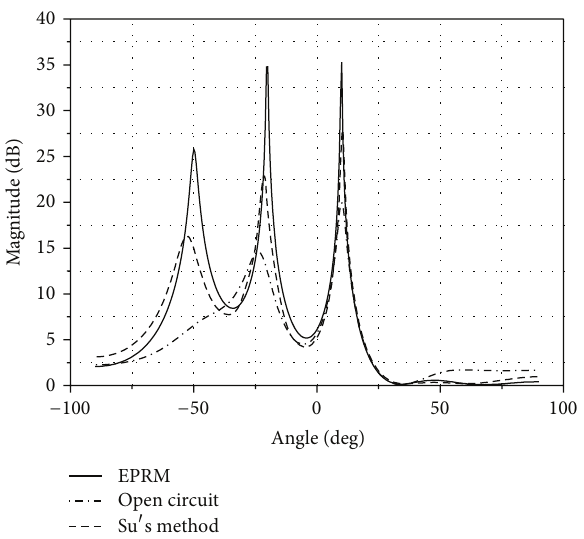
Figure 5: Spatial spectrum of the MUSIC algorithm for three incident signals.